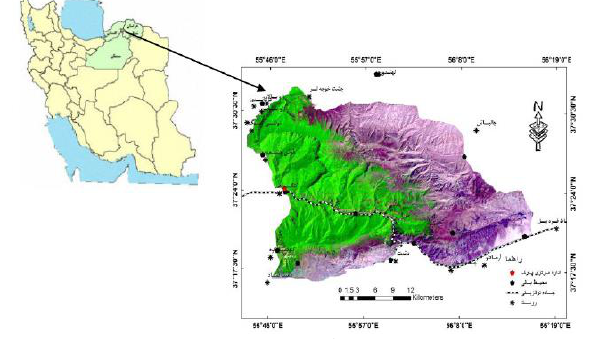
Figure 2. Location of the study